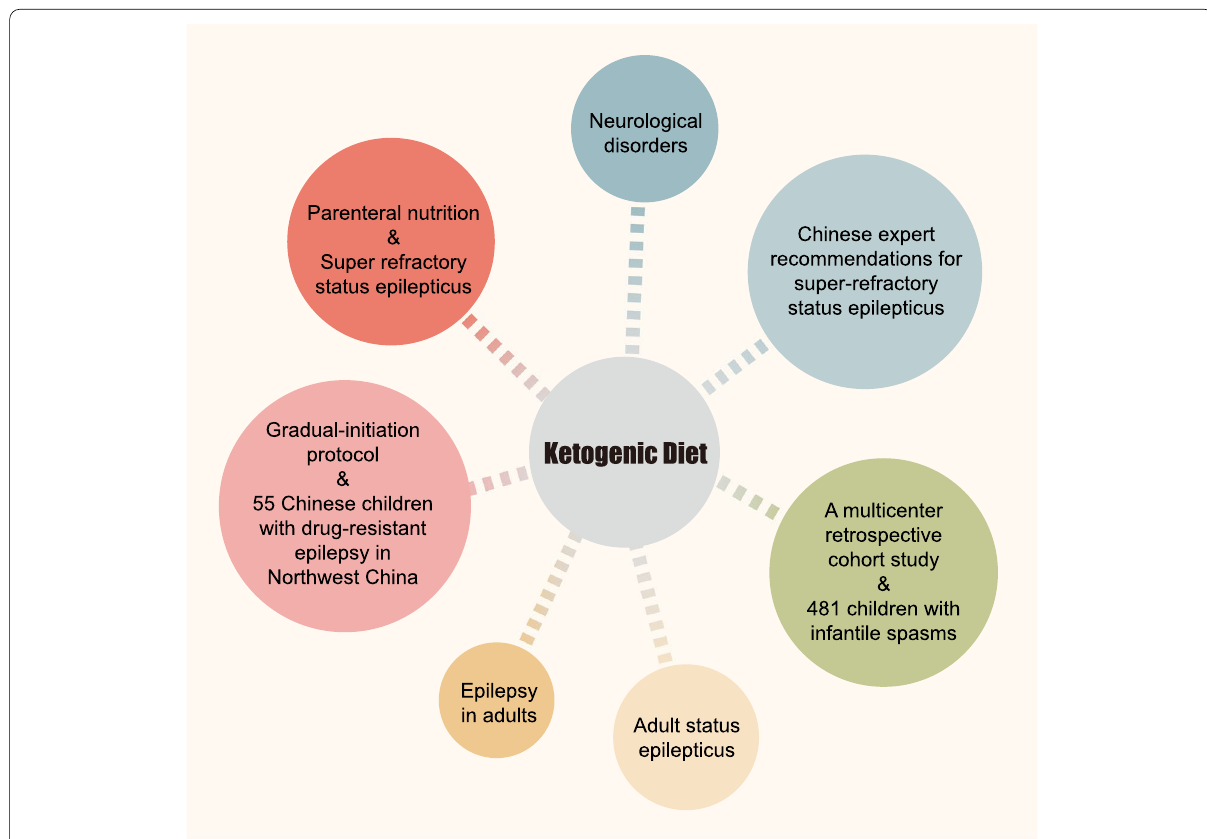
Fig. 1 Topics centered on ketogenic diet in this special